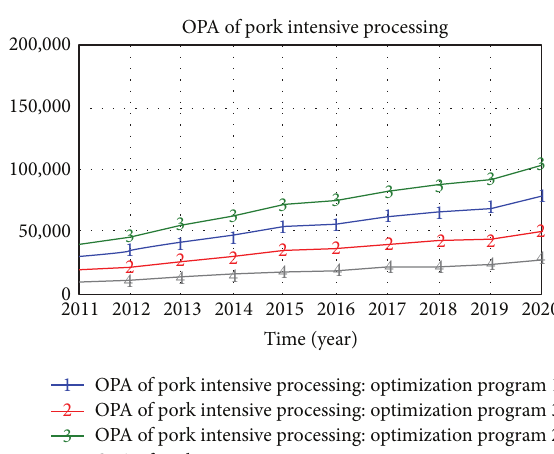
Figure 11: The output amount of intensive processing.